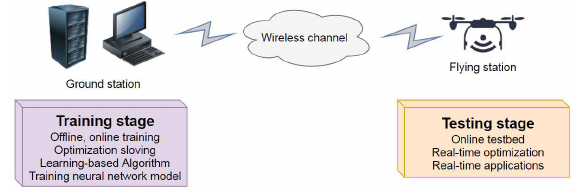
Figure 3. A practical model of UAV communication system with a ground station and a flying station.